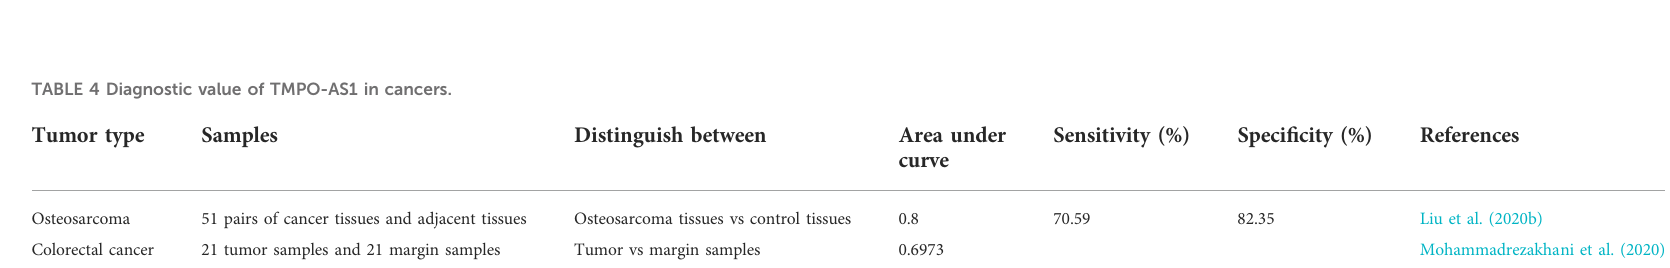
TABLE 4 Diagnostic value of TMPO-AS1 in